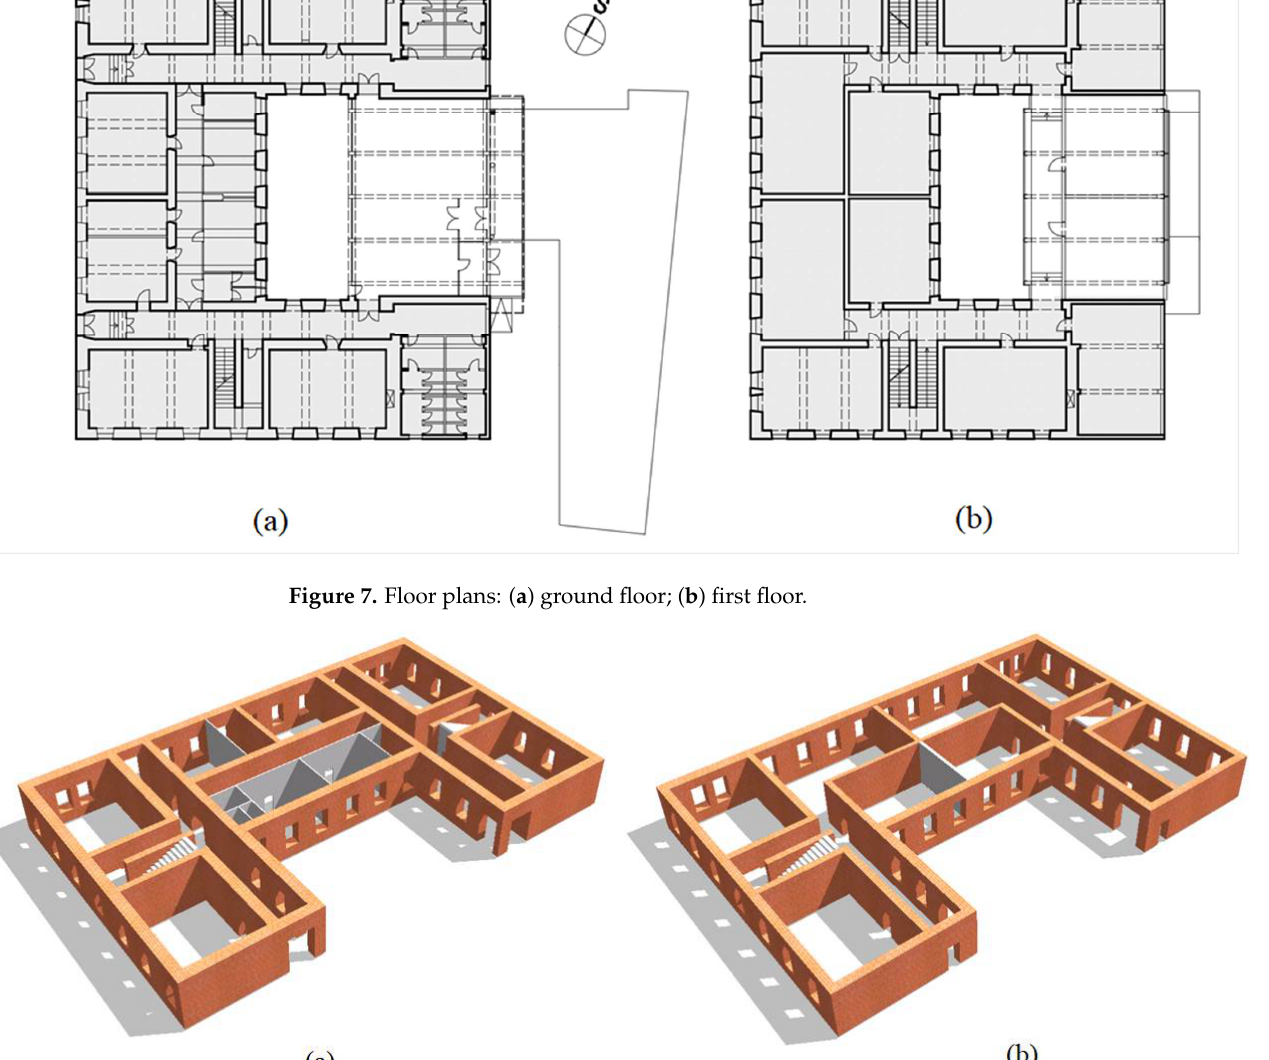
Figure 7. Floor plans: ( a ) ground floor; ( b ) first floor.